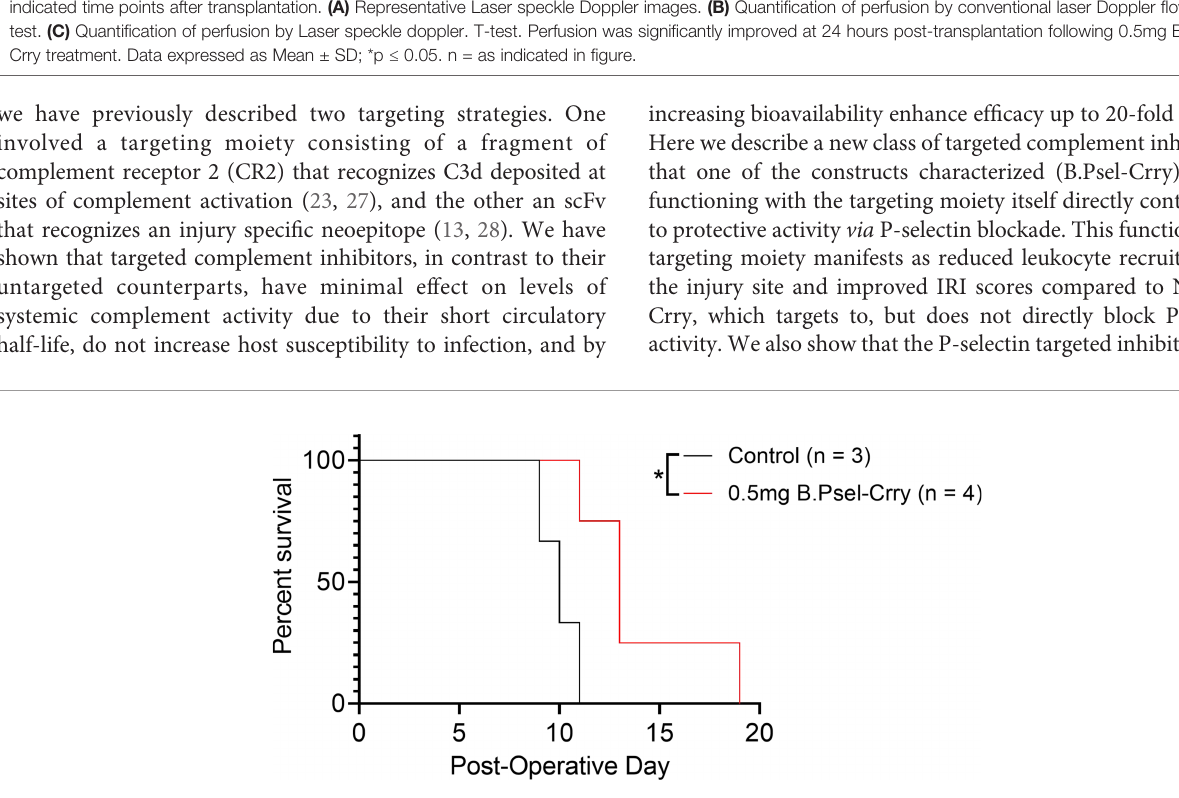
FIGURE 7 | B.PSel-Crry improves survival of hindlimb vascularized composite allografts. Allograft survival for orthotopic hindlimb VCA mice was classi fi ed as days until Banff clinical grade 4 rejection was reached. Graft survival curve comparing PBS and B.PSel-Crry treated groups. A single postoperative dose of 0.5mg B.PSel- Crry signi fi cantly improved hindlimb allograft survival. Mantel-Cox (log-rank) test. *p ≤